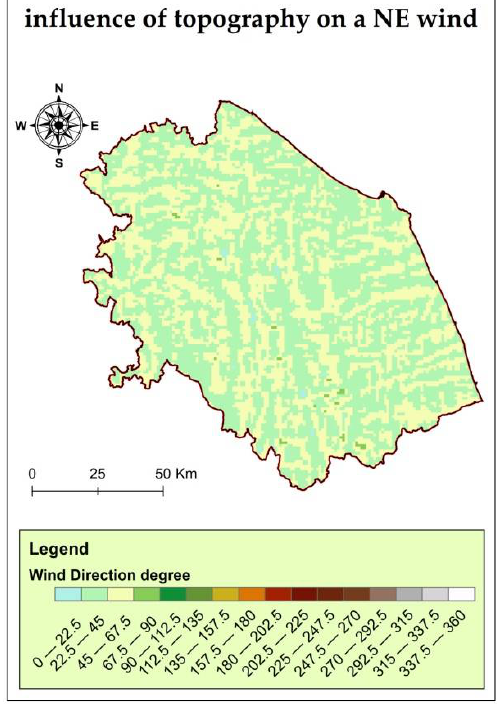
Figure 3. Example of the influence of the topography of the study area on the surface wind direction in the case of a north-easterly wind.